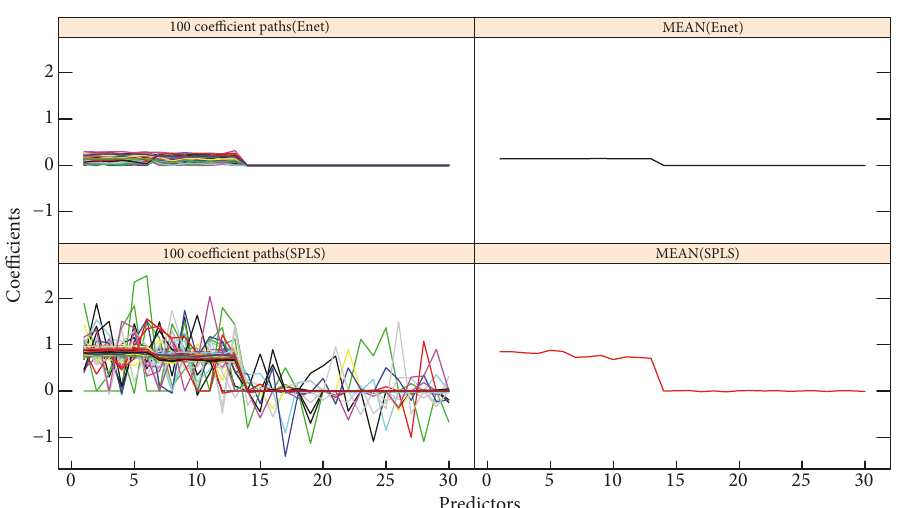
Figure 3: The left subgraphs are the coefficient paths by Enet and SPLS based on 100 replications, and the right subgraphs are the mean of coefficients by the two